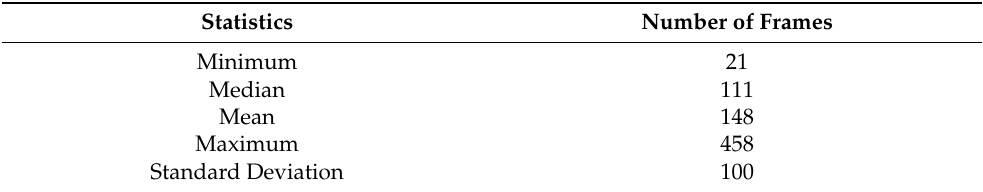
Table 3. Data related to the number of frames per video.